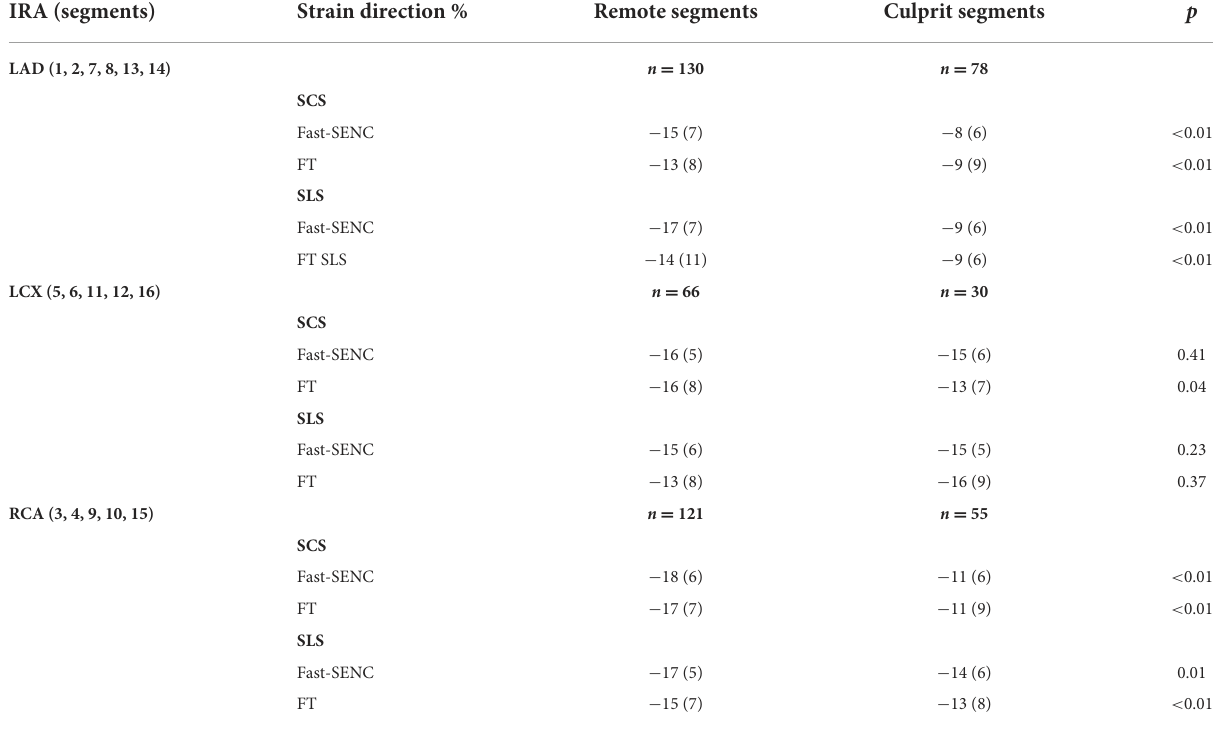
TABLE 4 Strain in culprit versus remote segments.